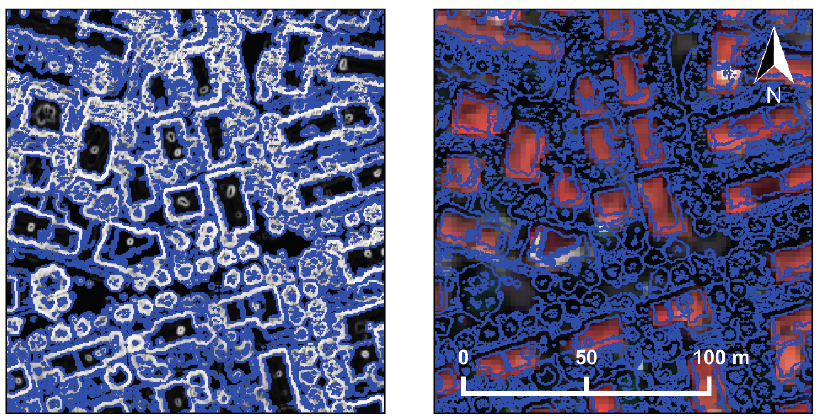
Figure 5. The result of the segmentation procedure plotted over the slope layer ( left ) and over the RGB composite ( right ).